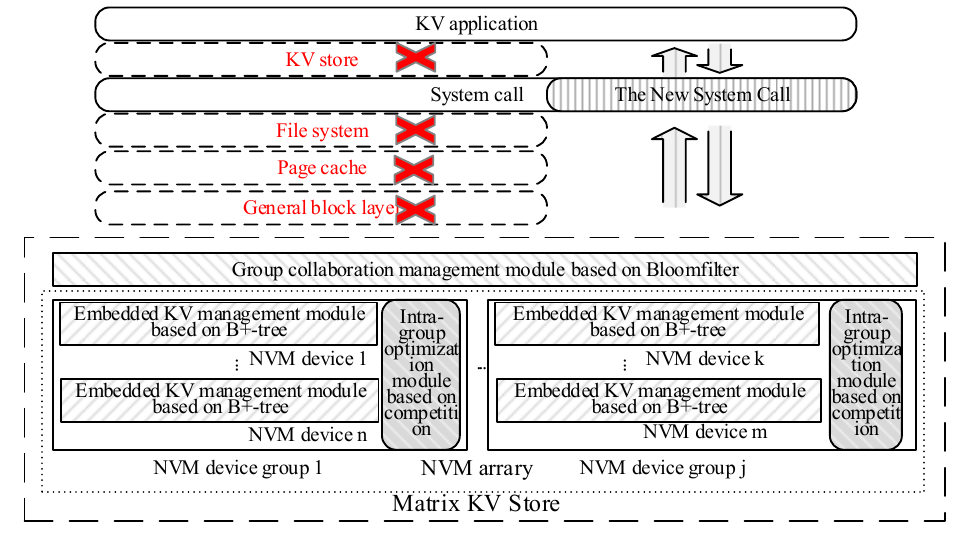
Figure 1. The structure of MKVS.